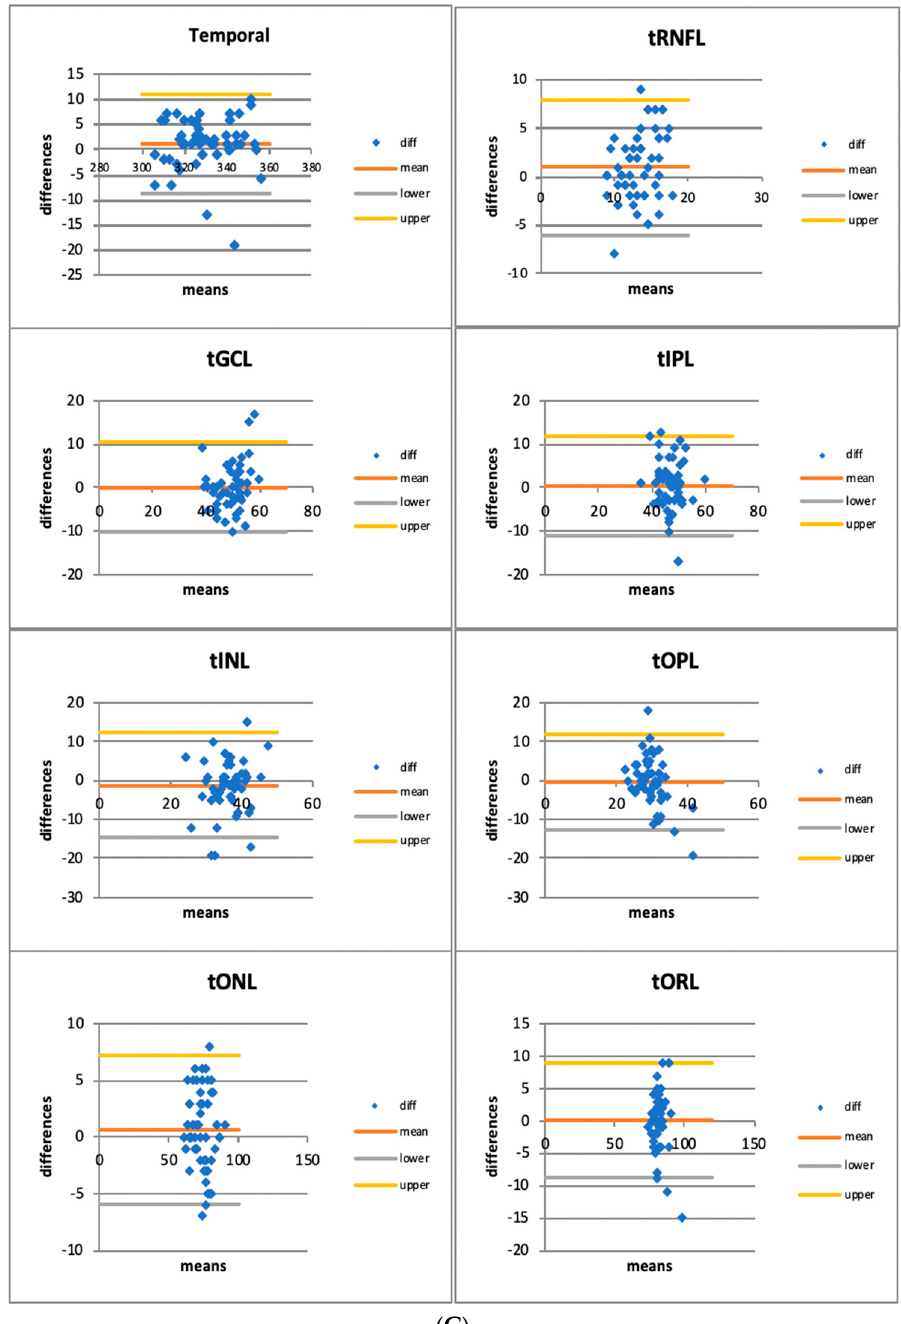
Figure 3. ( A ) Bland–Altman Plots for retinal layers thickness in the foveal area (f = foveal; RNFL: retinal nerve fiber layer; GCL: ganglion cell layer; IPL: inner plexiform layer; INL: inner nuclear layer; OPL: outer plexiform layer; ONL: outer nuclear layer; ORL: outer retinal layer). ( B ) Bland– Altman Plots for retinal layers thickness in the nasal area (n = nasal; RNFL: retinal nerve fiber layer; GCL: ganglion cell layer; IPL: inner plexiform layer; INL: inner nuclear layer; OPL: outer plexiform layer; ONL: outer nuclear layer; ORL: outer retinal layer). ( C ) Bland–Altman Plots for retinal layers thickness in the temporal area (t = temporal; RNFL: retinal nerve fiber layer; GCL: ganglion cell layer; IPL: inner plexiform layer; INL: inner nuclear layer; OPL: outer plexiform layer; ONL: outer nuclear layer; ORL: outer retinal layer).